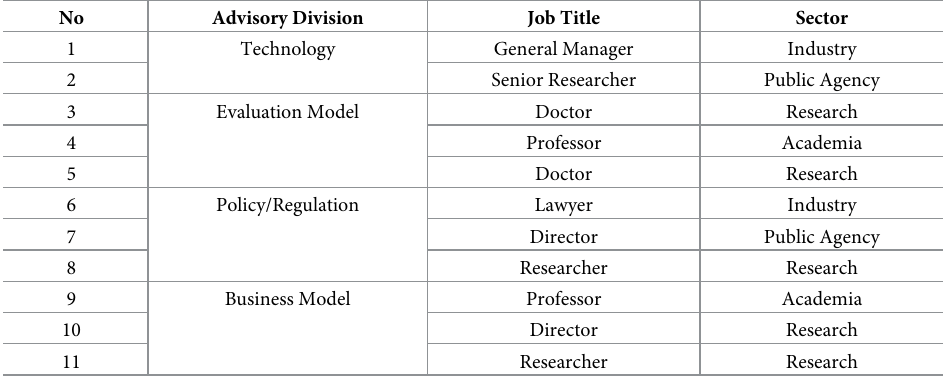
Table 4. The 11 expert panelists.